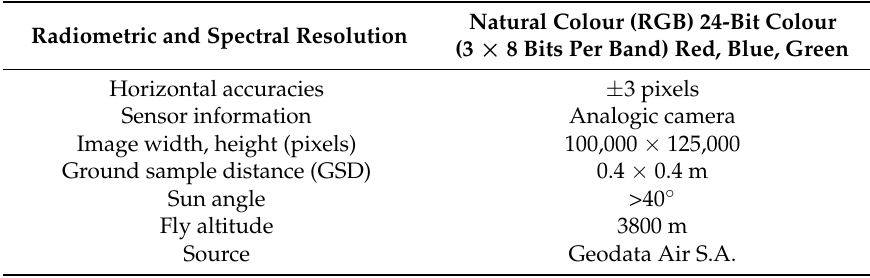
Table 1. The characteristic of the imagery used in the